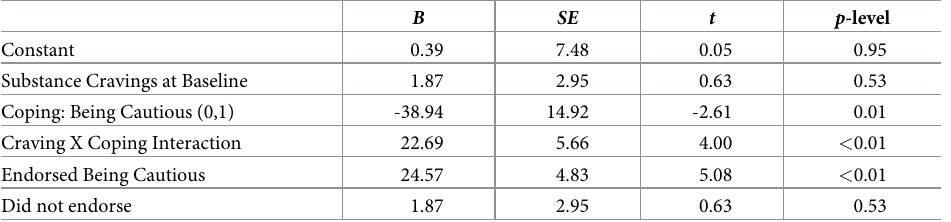
Table 6. Interaction between baseline substance cravings and being cautious to predict days using substances at